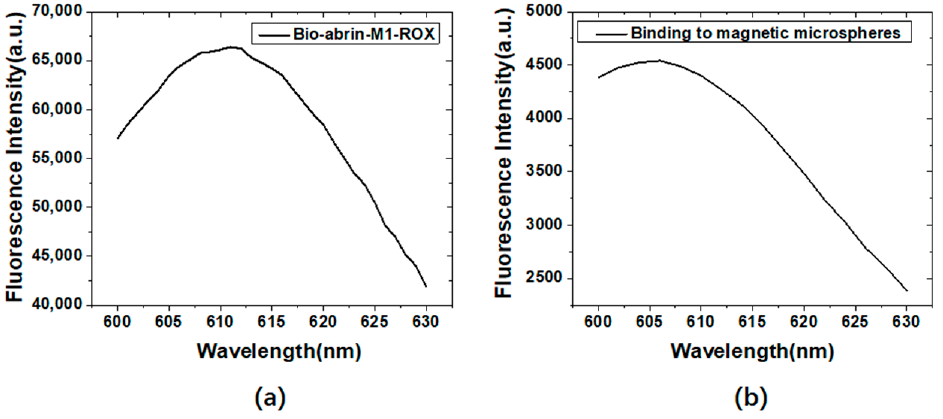
Figure 8. Fluorescence measurement results of ROX labeled abrin-M1 before ( a ) and after ( b ) bind- ing to streptavidin-coated magnetic microspheres.